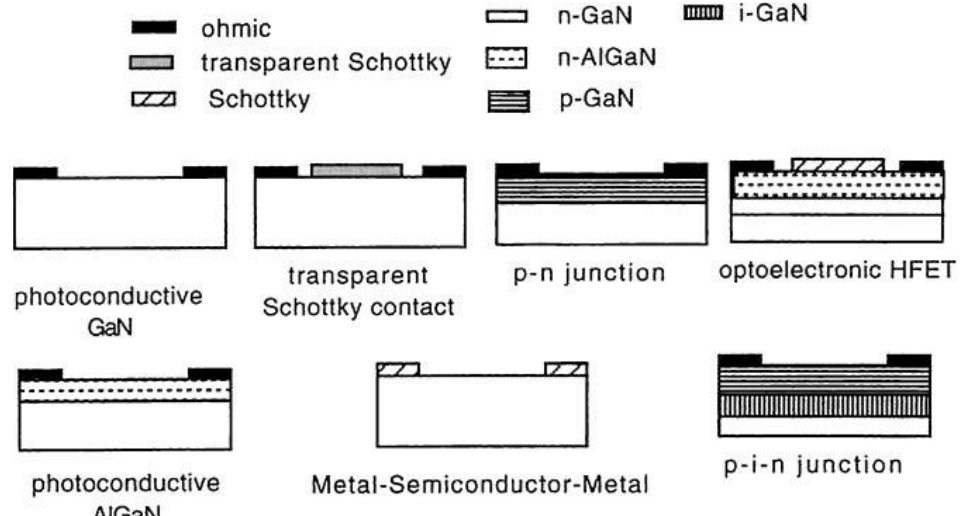
Figure 2. Schematic photodetector structures based on III-Nitride semiconductors. (Reprinted from Reference